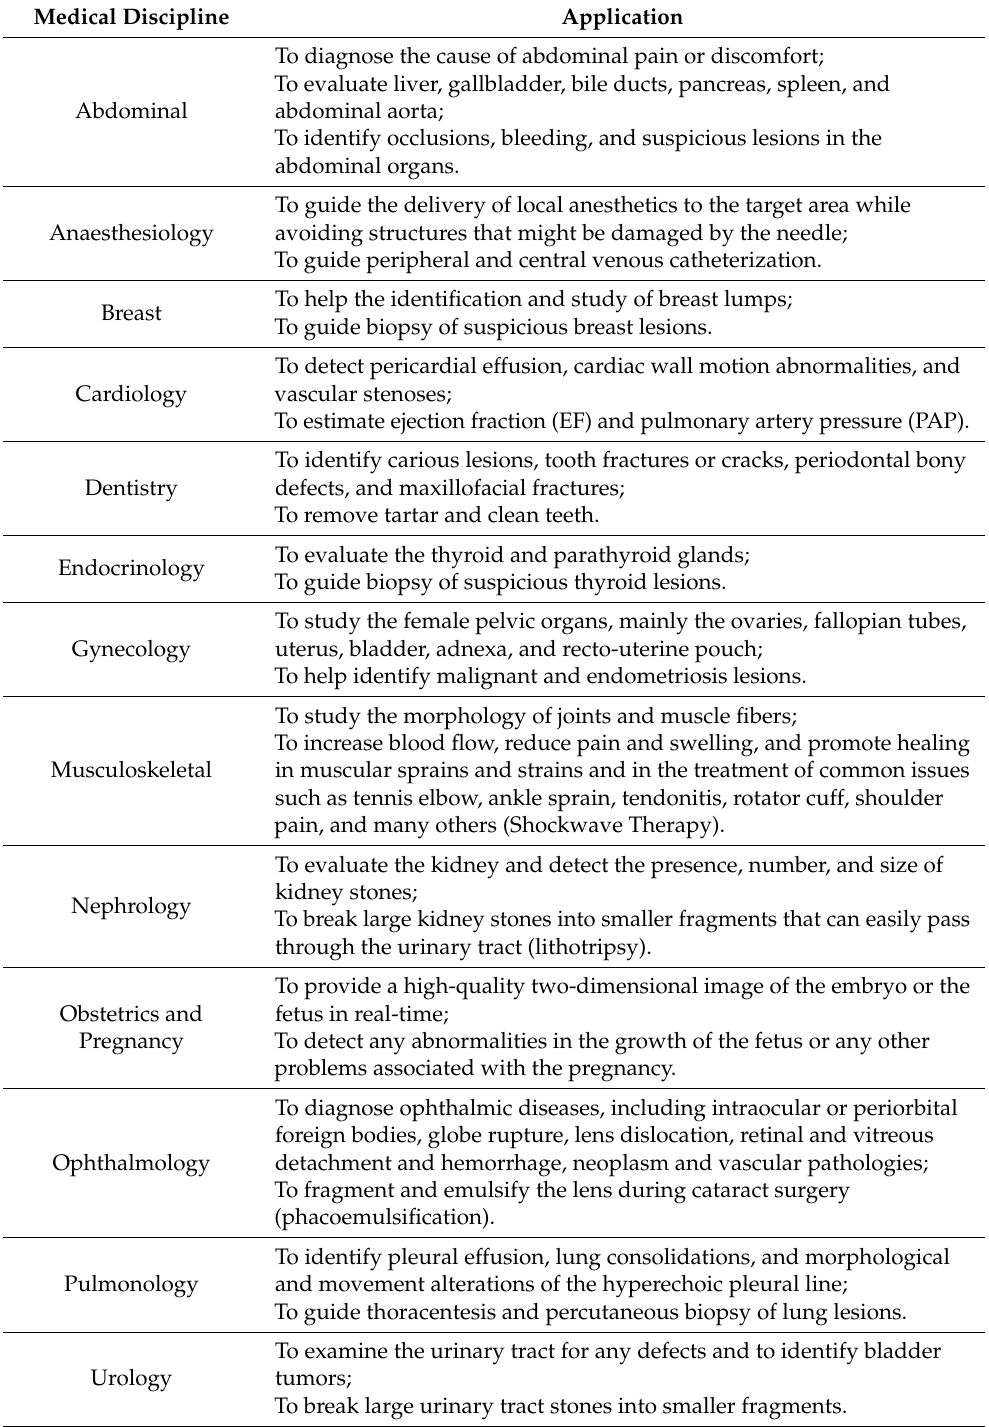
Table 1. Applications of ultrasound across different medical